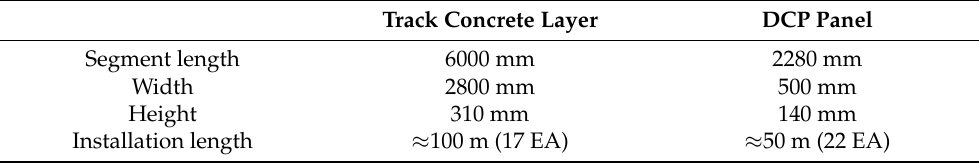
Table 1. The dimension information of the concrete track and DCP.